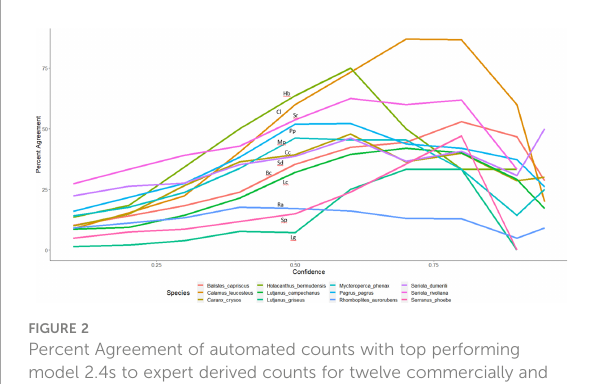
FIGURE 2 Percent Agreement of automated counts with top performing model 2.4s to expert derived counts for twelve commercially and ecologically important species of reef fi sh commonly observed in the Gulf of Mexico. Lines are labeled with the initials of the species name in the legend. Species with high percent agreement coupled